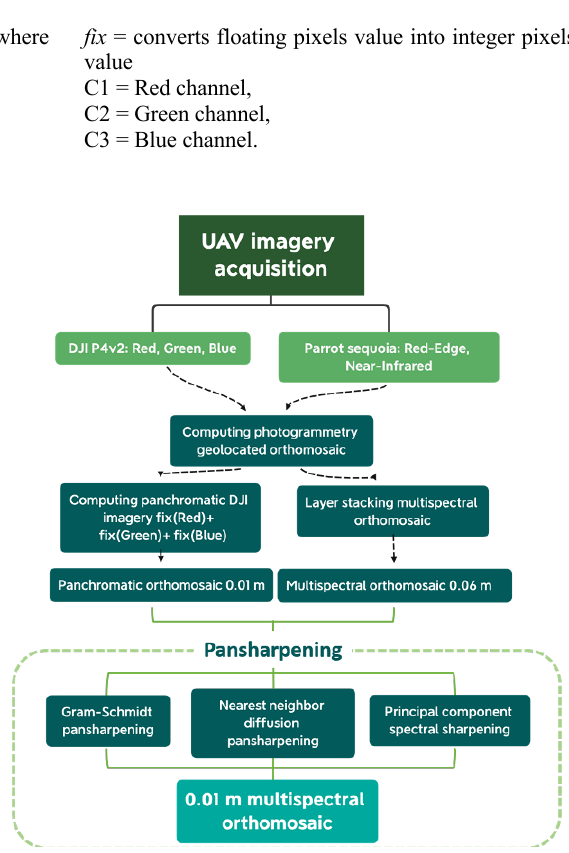
Figure 2. Work chart of the UAV imagery multispectral orthomosaic pansharpening.